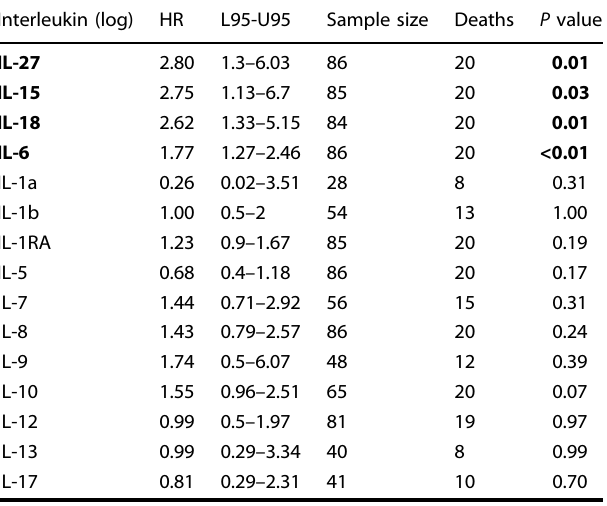
Table 2. Hazard ratios of circulating cytokines from IU COVID-19